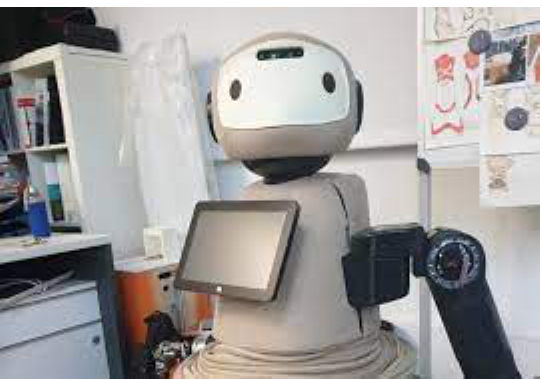
Figure 1. IVO Robot. New design of a humanoid robot for citizen